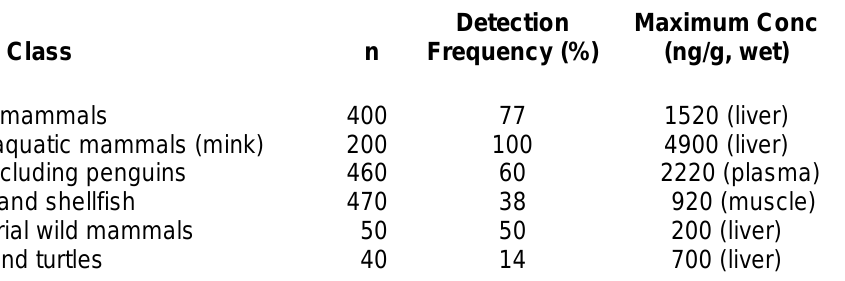
Frequency and Maximum Concentrations of Detection of PFOS in Animal Tissues